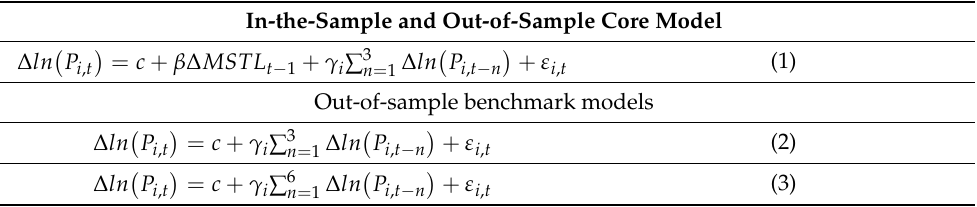
Table 1. The main econometric models for both the core and benchmark models. In-the-Sample and Out-of-Sample Core Model